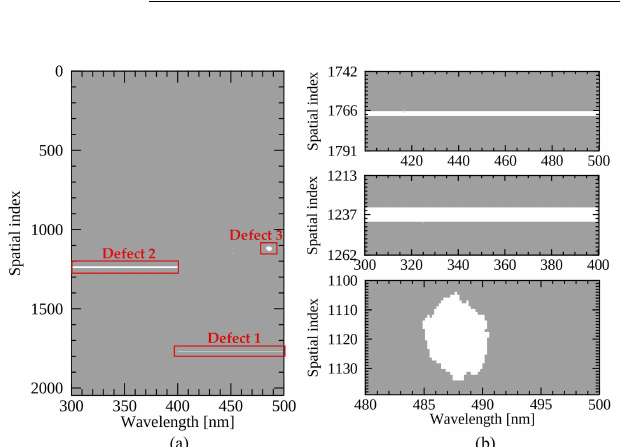
Figure 1. The two-dimensional bad-pixel map (a) on the GEMS CCD detector along the spectral ( x axis) and spatial direction ( y axis) and (b) zooming in on the bad-pixel positions from top to bottom rows for Defects 1–3. Bad pixels are marked in